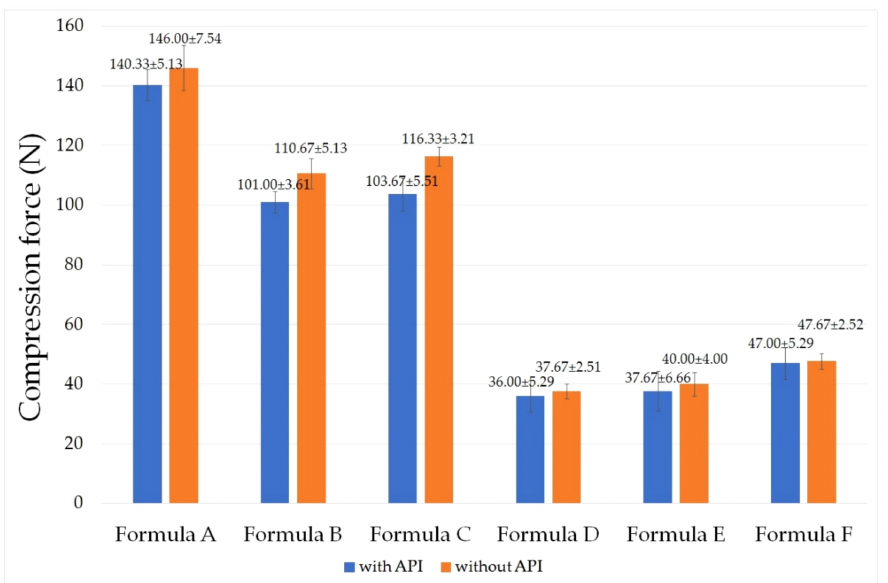
Figure 2. Result of the texture analysis of the formulations at 24.5 ± 0.5 ◦ C, determined as compres- sion force (N). Compositions containing the active pharmaceutical ingredients (APIs) were signed with blue columns, and compositions without APIs were signed with orange columns. Each data point represents the mean ± S.D., n = 3.